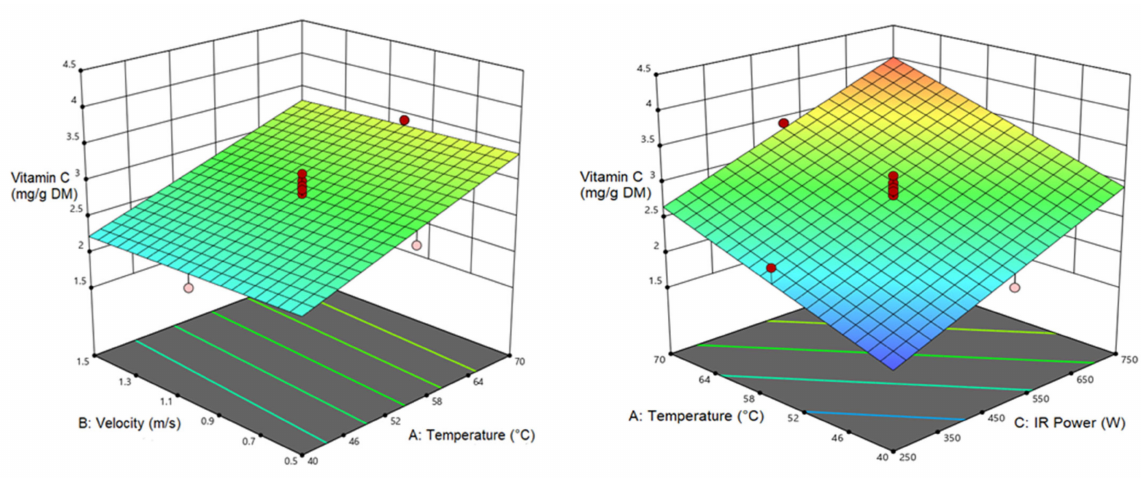
Figure 8. Interaction of air temperature/air velocity and air temperature/IR power on VC of pumpkin.